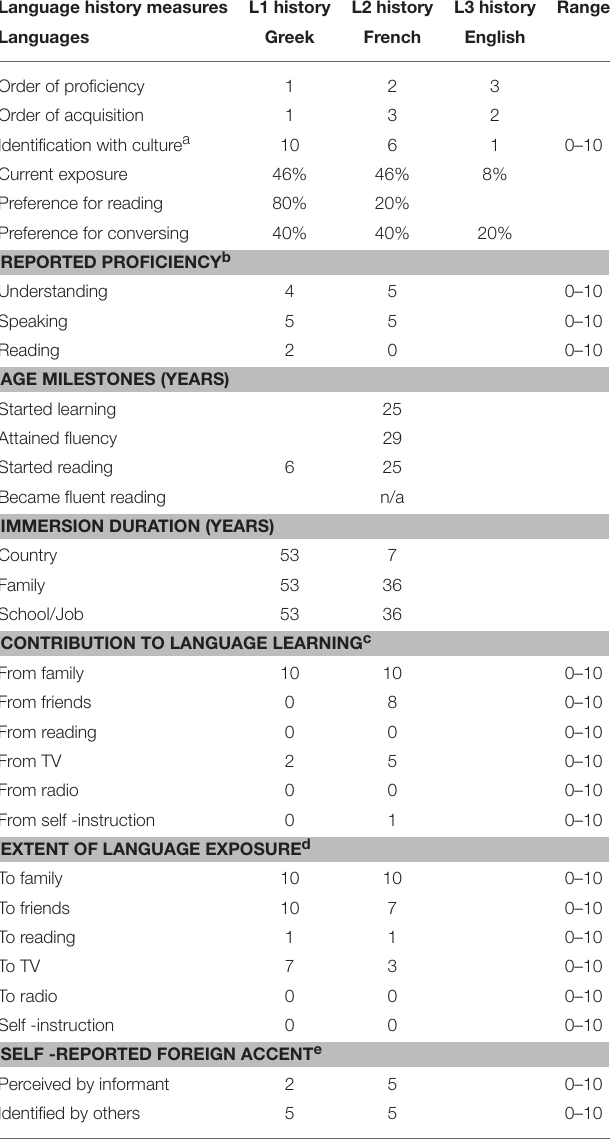
TABLE 1 | Reported language history and proficiency for participant LJ based on the Language Experience and Proficiency Questionnaire (LEAR-Q, Marian et al.,